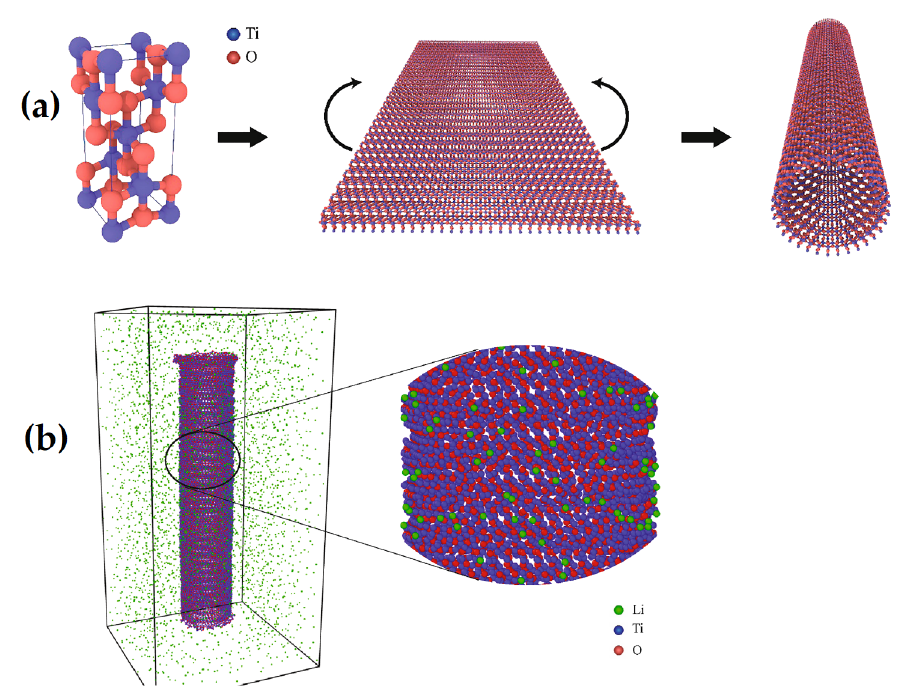
Figure 13. ( a ) Construction of anatase NT (red spheres: Ti, blue spheres); ( b ) simulation box (red spheres: Ti, blue spheres: O, green spheres: Li). Reprinted with permission from Ref. [170]. Copy- right©2021 Elsevier